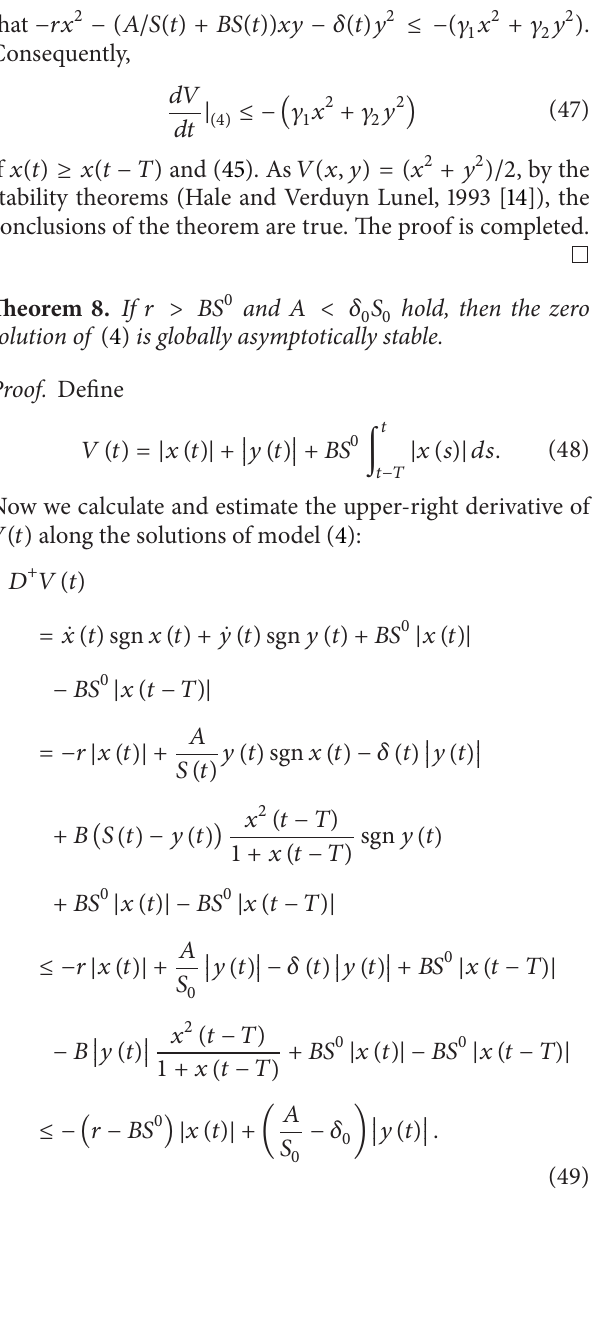
that −𝑟𝑥 2 − (𝐴/𝑆(𝑡) + 𝐵𝑆(𝑡))𝑥𝑦 − 𝛿(𝑡)𝑦 2 ≤ −(𝛾 1 𝑥 2 + 𝛾 2 𝑦 2 )